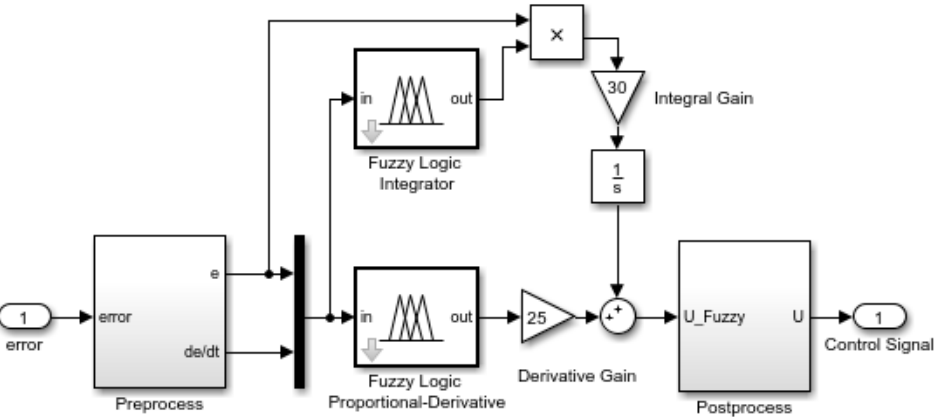
Figure 11. Structure of a fuzzy PID